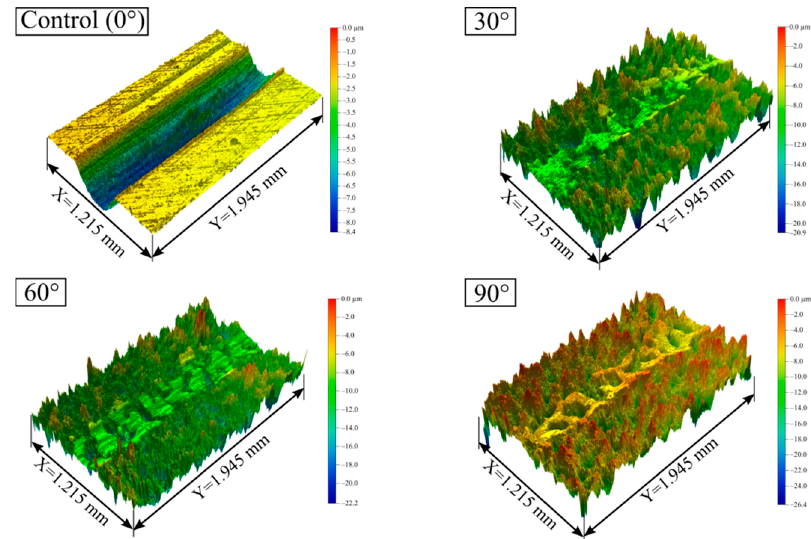
Figure 9. Three-dimensional wear morphology at different jet angles of SGP.